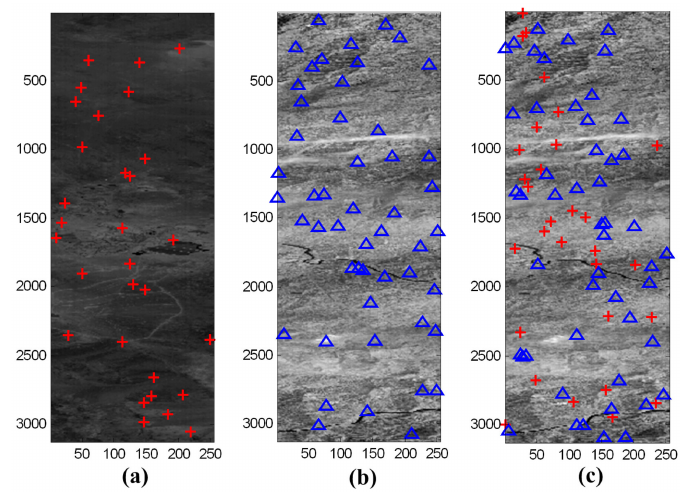
Figure 5. ( a ) Measurement scene and ( b ) verification scene of the proposed method. ( c ) Measurement and verification scene of the rational functional model (RFM) method (30 GCPs and 50 random check points (RCPs)).